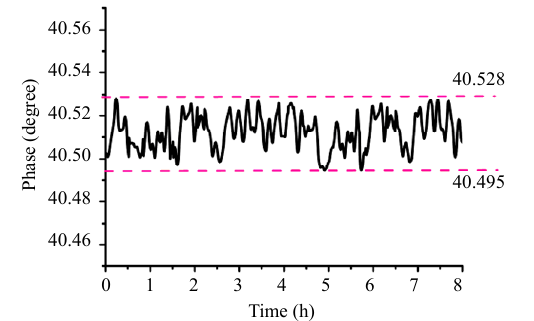
Fig. 7 Measurement of 3% concentration for a period of